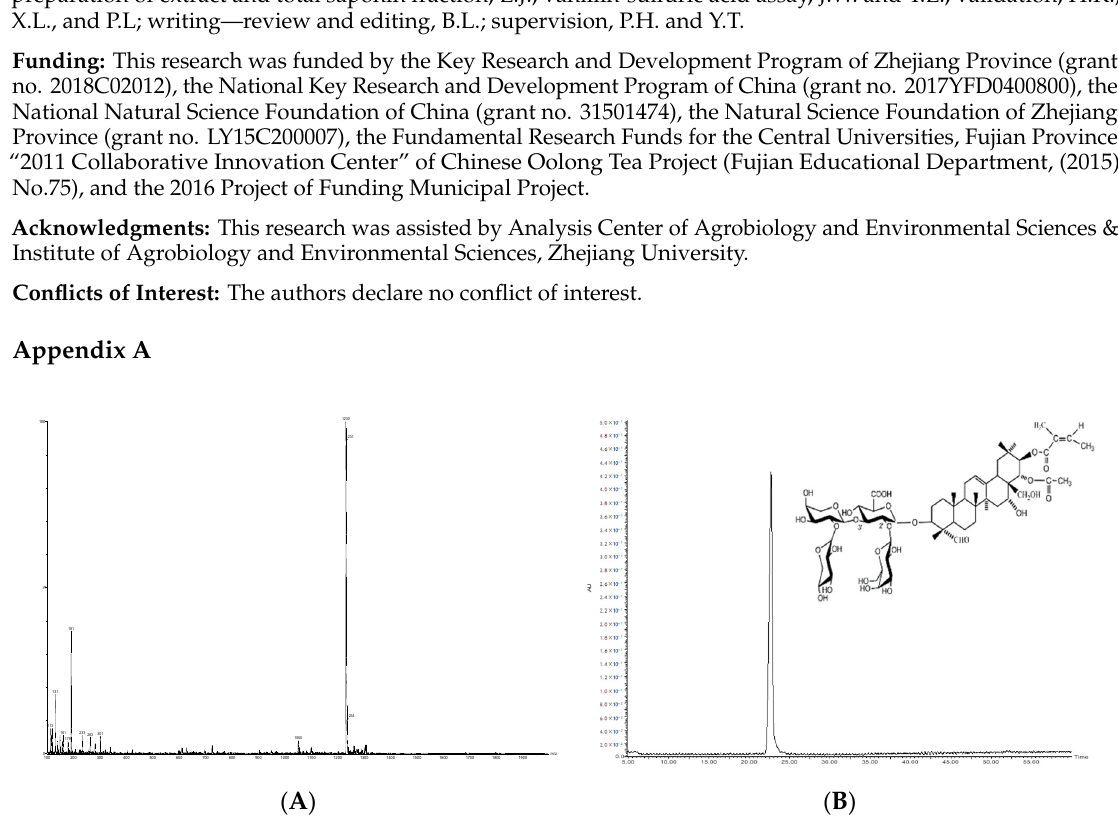
Figure A1. UPLC-PDA-MS chromatogram of theasaponin E 1 prepared in this work. ( A ) UPLC-UV chromatogram detected at 210 nm and chemical structure of theasaponin E 1 . ( B ) MS spectra of theasaponin E 1 in negative ion mode. Table A1. 13 C- and 1 H-NMR spectral data of theasaponin E 1 prepared in this work (pyridine-d5). Carbon